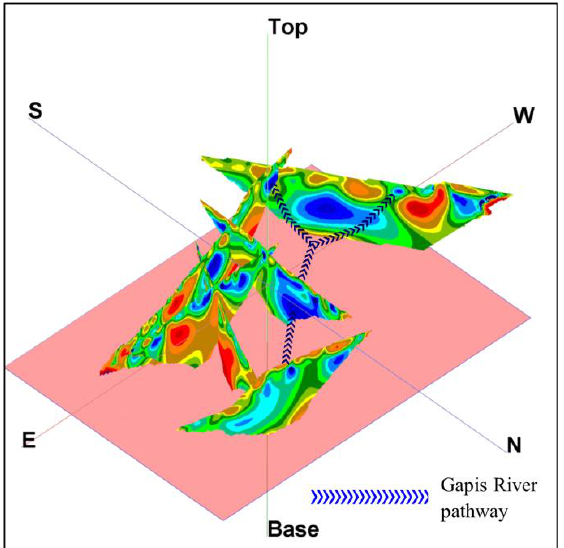
Figure 8. Three-dimensional (3-D) model of resistivity result with Gapis River pathway.